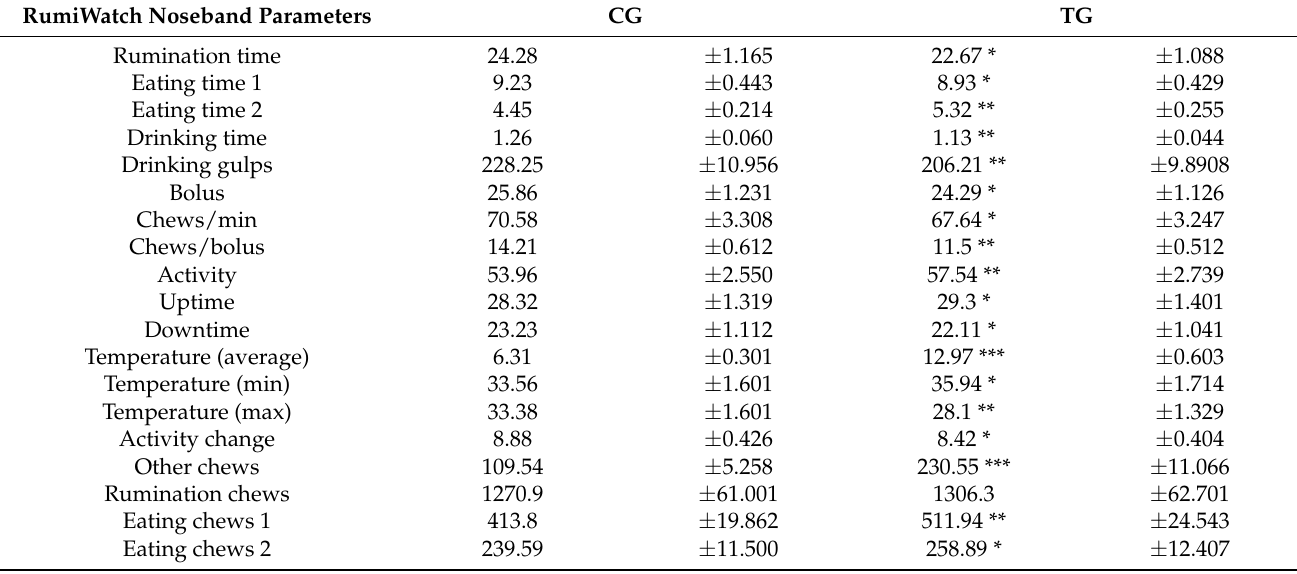
Table 3. RumiWatch noseband (RWS) parameters before calving (from day “ − 30” to day “ − 1”) by